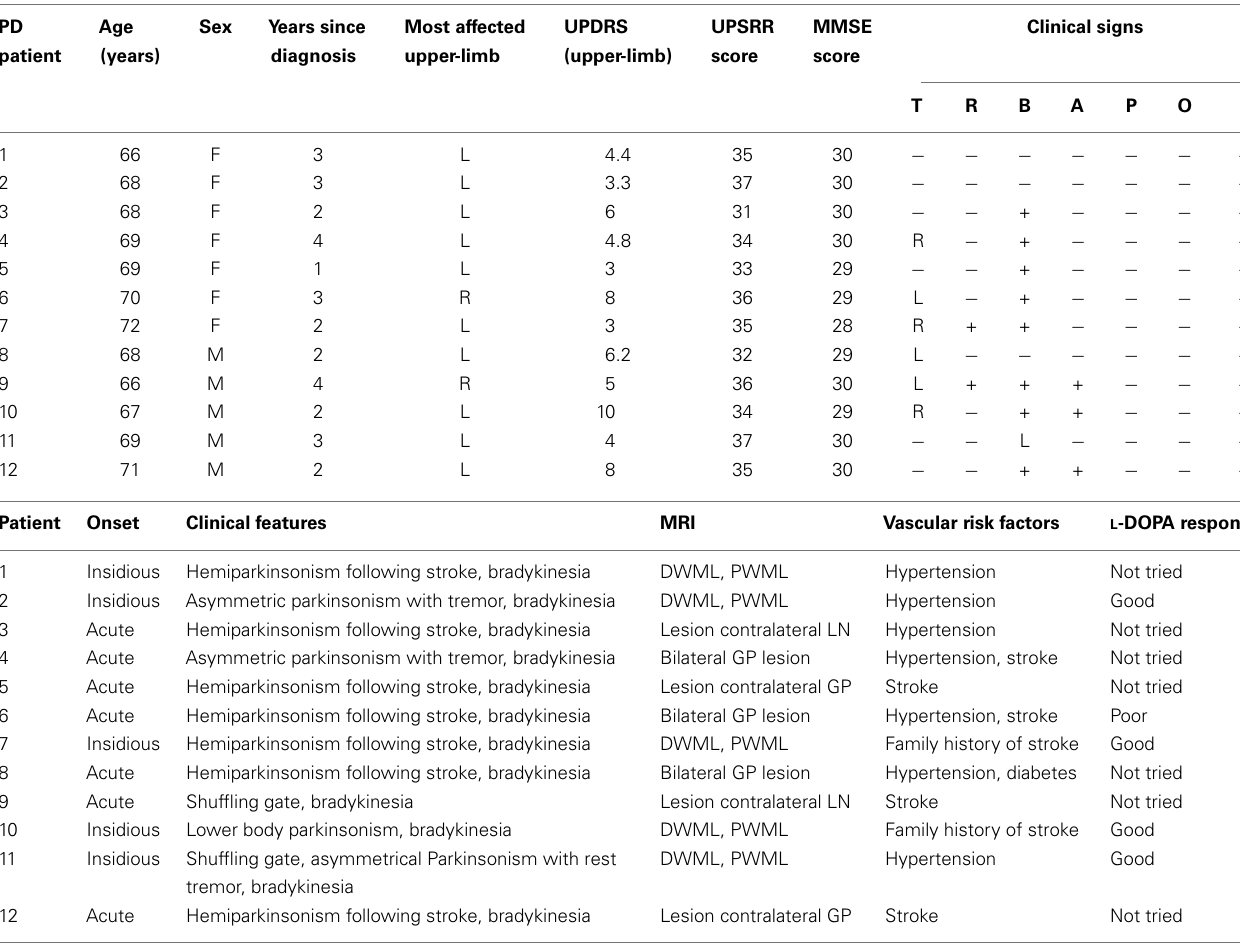
Table 1 | Demographic data and clinical features of the patients with vascular parkinsonism (VPD) studied